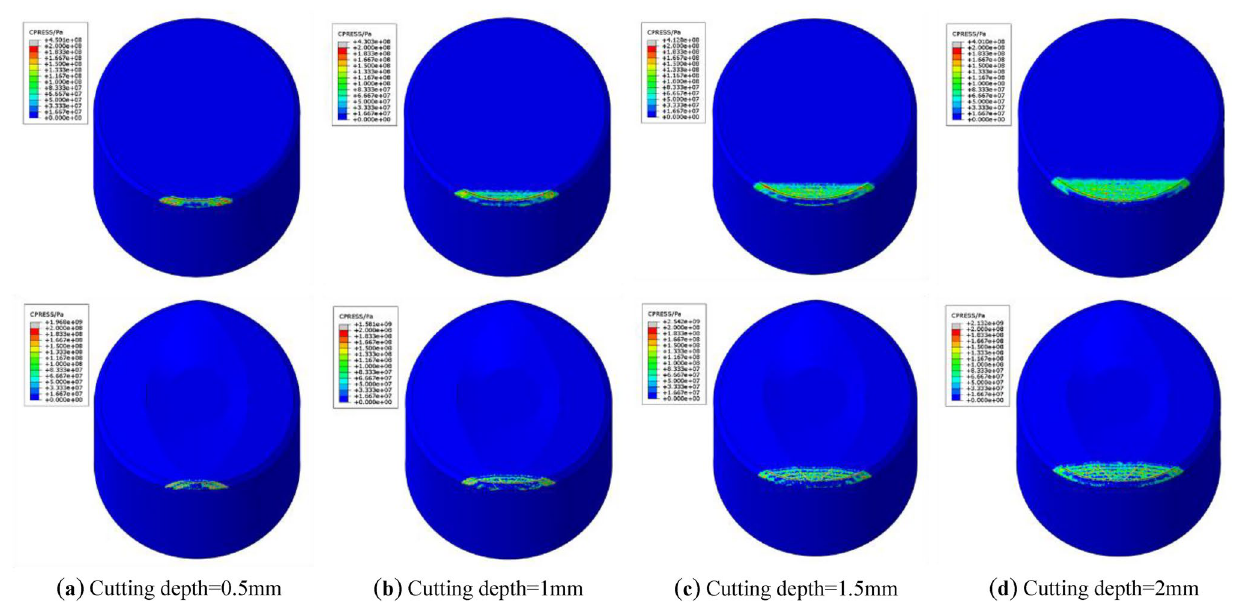
Fig. 18 Contact stress for a flat/3D concave-shaped cutter at different penetration